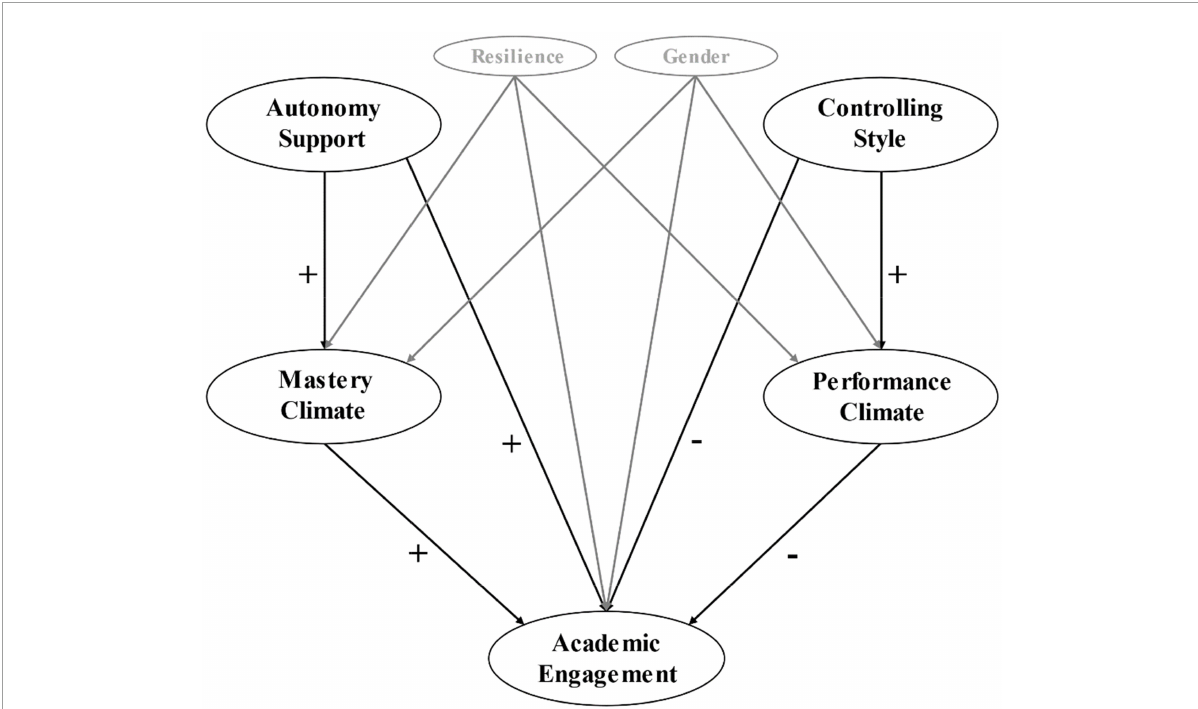
FIGURE1 Predictive relationships of the interpersonal teaching style on academic engagement through the mediating role of the motivational climate, controlling the gender and resilience